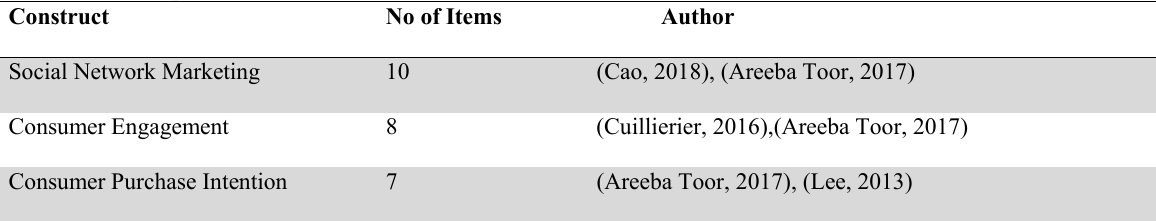
Constructs Adopted